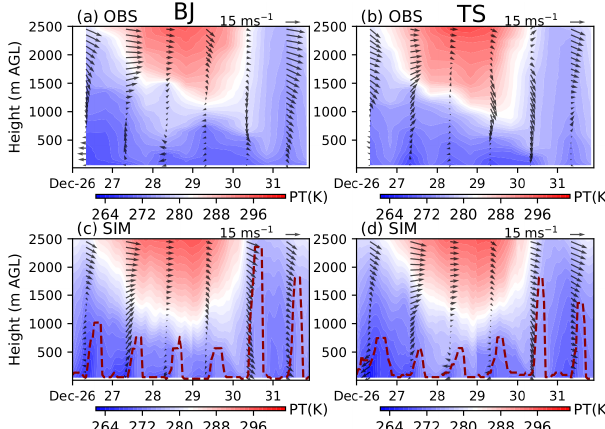
Figure 5. Vertical structure of (a, b) observed and (c, d) simulated PT and horizontal winds in Beijing and Tangshan from 26 to 31 De- cember in 2017. The simulated profiles are derived from the BASE run, and the boundary layer height (BLH) is denoted by the dashed red lines in (c, d)